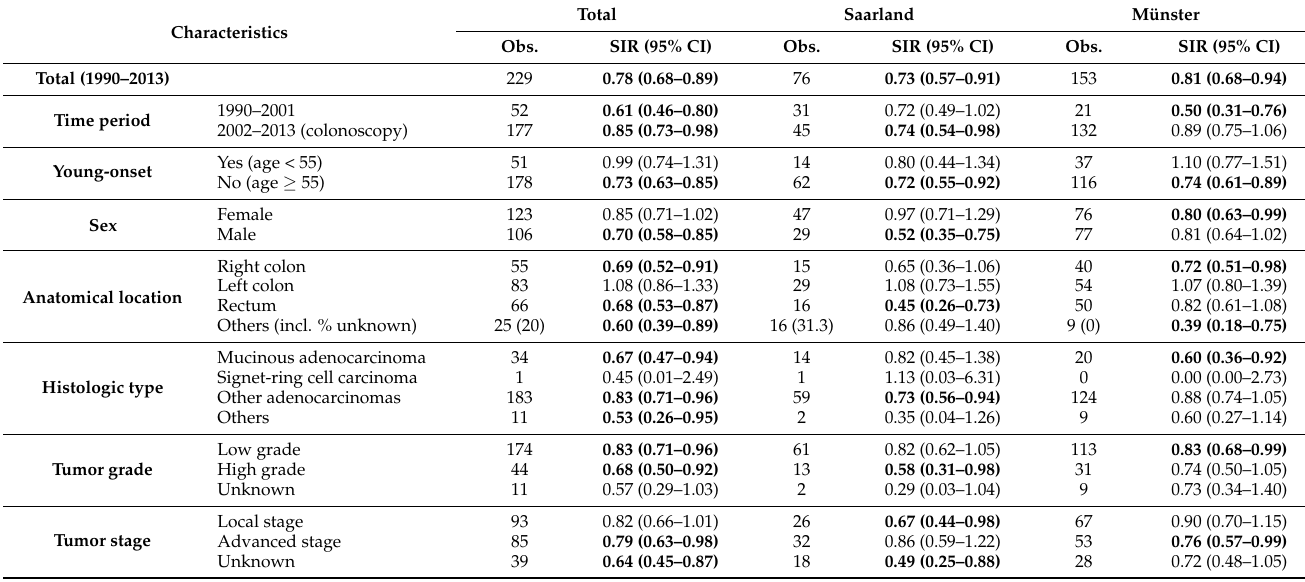
Table 2. Standardized incidence ratios of resettlers compared to the general Saarland (1990–2009) and Münster (1994–2013) population with exact 95% confidence intervals.